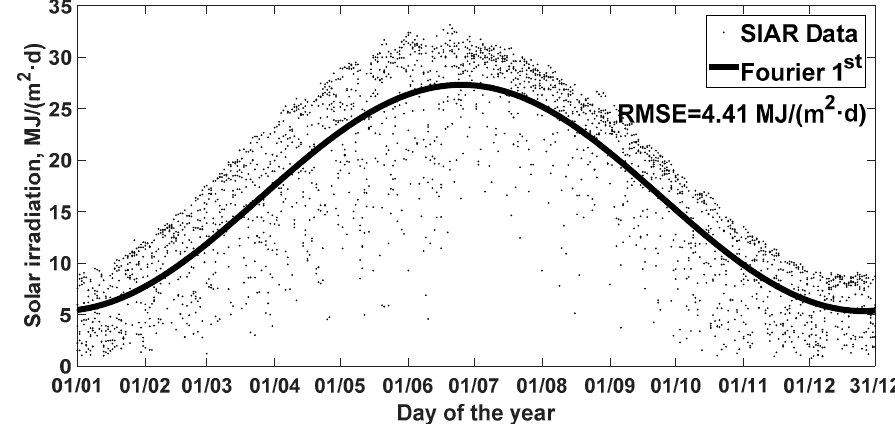
Figure 10. Typical annual Fourier model with the first harmonic for the horizontal daily global solar irradiation [H(t), MJ/(m 2 ·d)]. Data for the SIAR agrometeorological station at Mansilla Mayor, León, Spain, for seven years series.